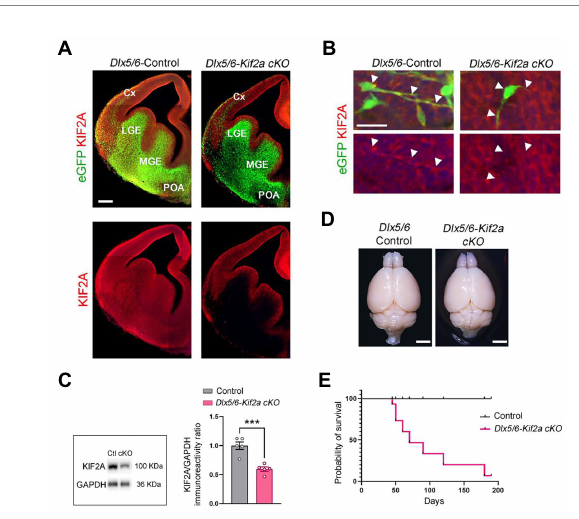
FIGURE 1 Conditional deletion of KIF2A in the mouse forebrain GABAergic neurons results in short survival. (A) Coronal sections of control and Dlx5/6-Kif2a cKO embryos showing the expression of Dlx5/6-Cre- eGFP (green) and KIF2A (red) at embryonic day 13.5 (E13.5). (B) Representative images of migrating neuron in control and Dlx5/6- Kif2a cKO embryos. White arrowheads delineate neuronal shape. (C) Western blot analysis and quantification of the relative amount of KIF2A from control (Ctl) and Dlx5/6-Kif2a cKO (cKO) adult telencephalon ( n = 5 mice per genotype). (D) Representative images of whole brains of the indicated genotypes at P40. (E) Kaplan–Meier curve depicting a decrease in survival of Dlx5/6-Kif2a cKO as compared to control mice ( n = 9 mice per genotype). Cx, cortex; LGE, lateral ganglionic eminence; MGE, medial ganglionic eminence; POA, preoptic area. Scale bars (A) 200 μ m, (B) 25 μ m, (D) 2 mm. Data are represented as mean ± SEM. Values were obtained by unpaired Student’s t-test; * p < 0.05, ** p < 0.01, and *** p <